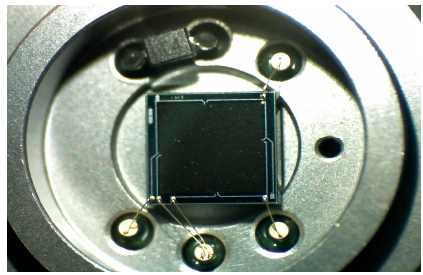
Figure 1. Packaging of the piezoresistive pressure sensor.